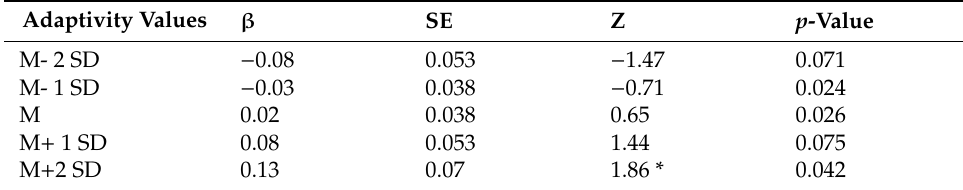
Table 5. Conditional e ff ects at adaptivity (mean and ± 2 SD) on PEU- > CC- > Stickiness. Adaptivity Values β SE Z p -Value M- 2 SD − 0.08 0.053 − 1.47 0.071 M- 1 SD − 0.03 0.038 − 0.71 0.024 M 0.02 0.038 0.65 0.026 M + 1 SD 0.08 0.053 1.44 0.075 M + 2 SD 0.13 0.07 1.86 *